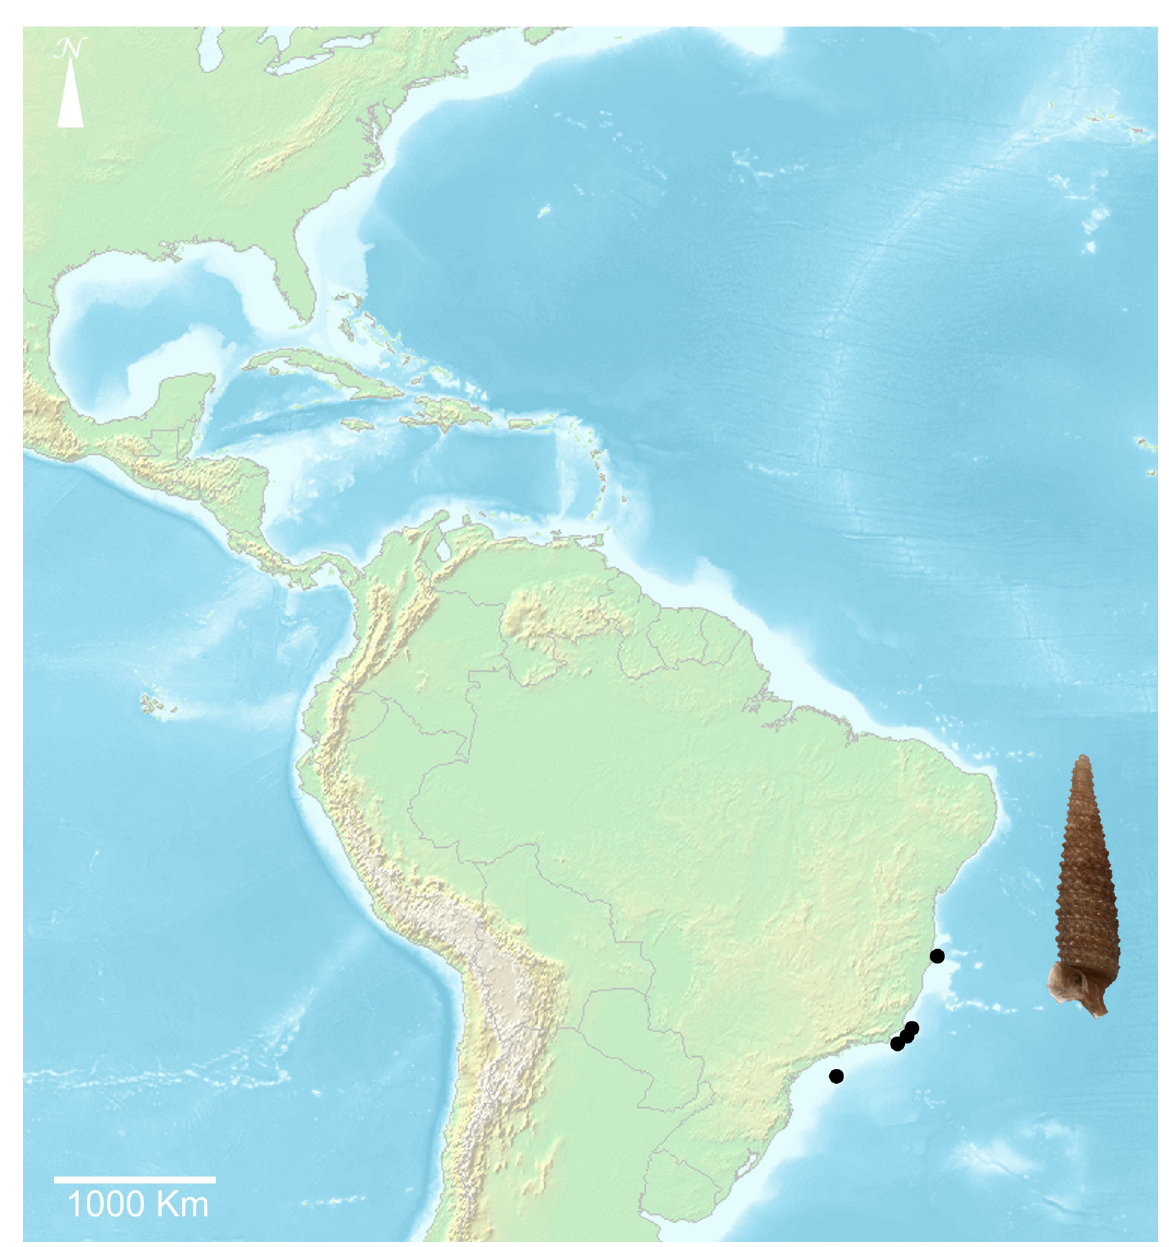
Fig. 45. Distribution map of “ Inella ”